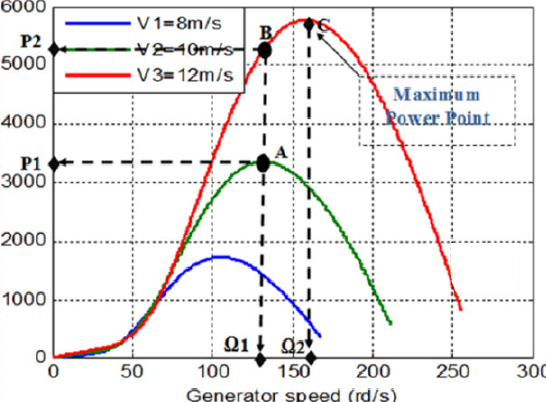
Figure 5. Aerodynamic power for di ff erent wind speed values as a function of mechanical speed.